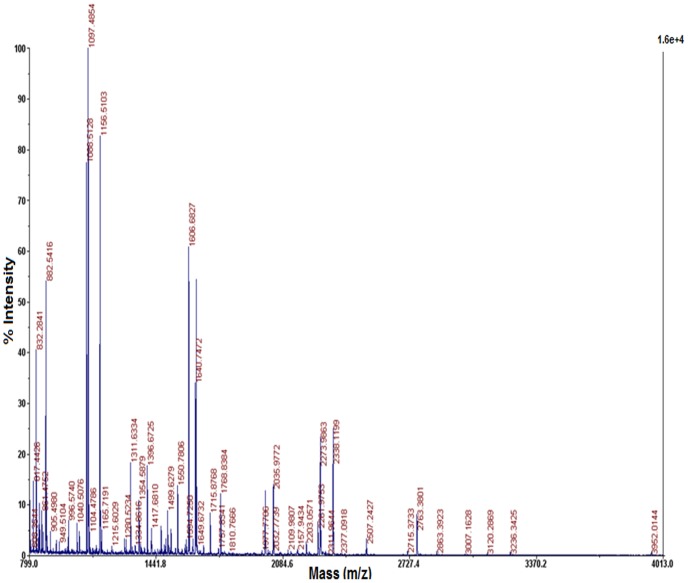
MALDI-TOF spectrum of trypsin digested peptides of FMSF.Three concentrations of the same sample were spotted on the CHCA matrix for analysis, which produced qualitatively identical results. All the peaks on the spectrum were checked for homology in the online protein database; only those with a score >65 were considered significant for discussion in the result section.